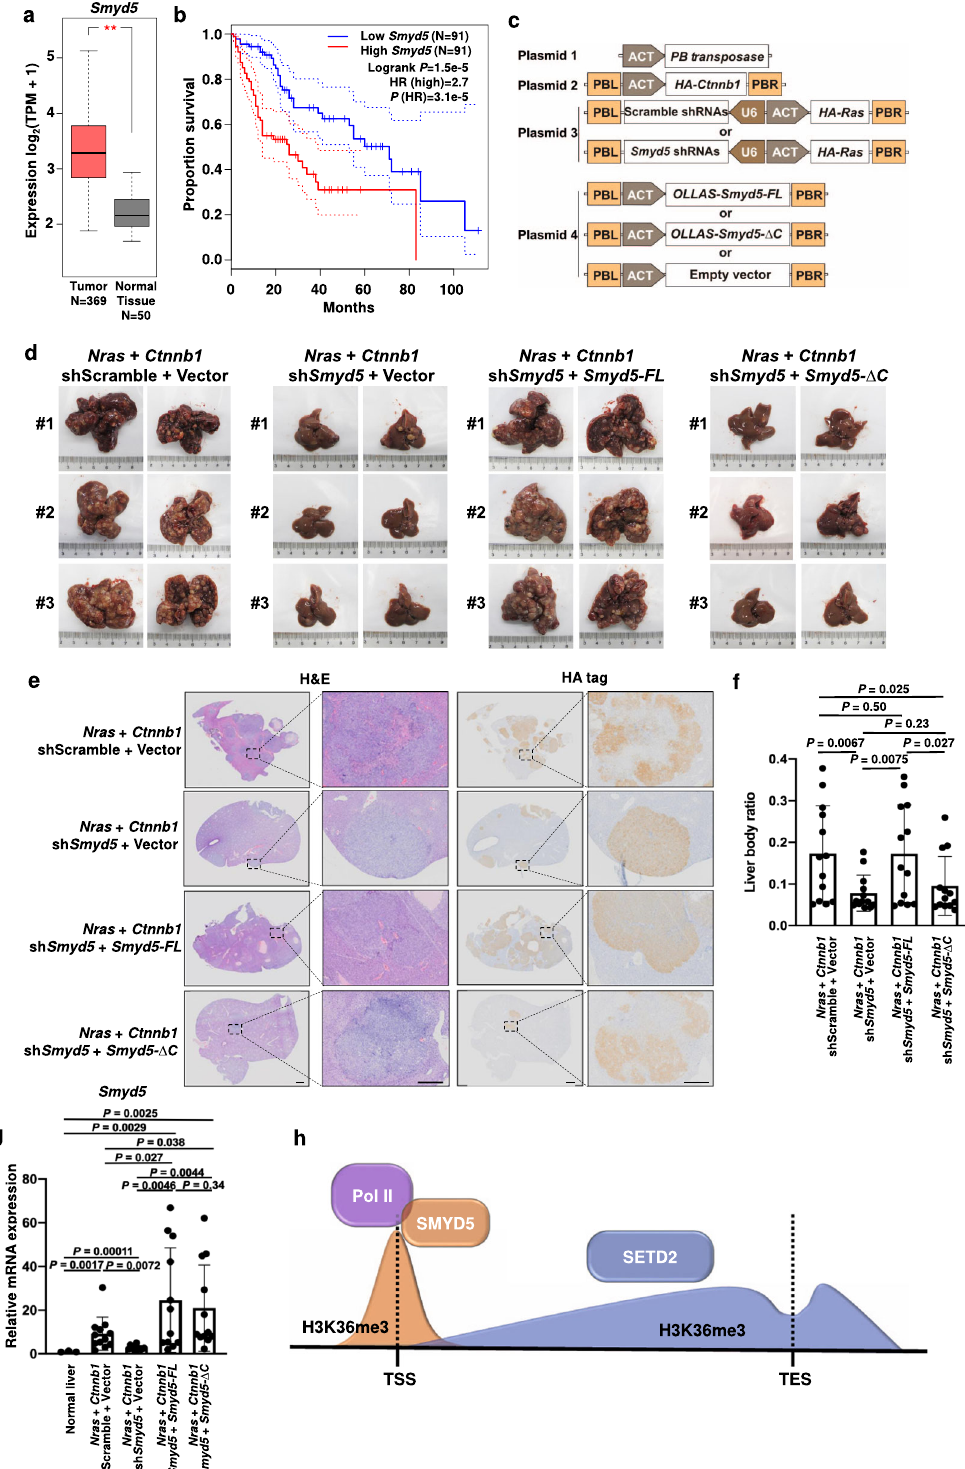
SMYD5 to promote sperm chromatin remodeling 52 . SMYD5 deposits H4K20me3 at heterochromatin regions with repetitive DNA elements to maintain chromosome integrity and maintain mESC self-renewal 53,54 . Here, we uncovered that SMYD5 is recruited by Pol II to catalyze H3K36me3 at promoters. SETD2 is considered the only H3K36me3 methyltransferase, because depletion of SETD2 greatly reduces the total level of